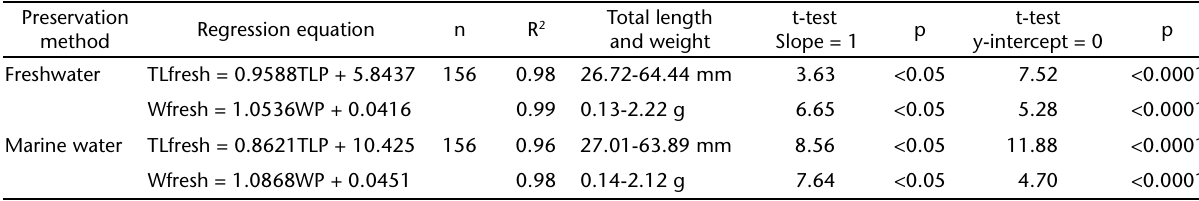
Table I. Correction equations to estimate the weight and total length for juvenile A. brasiliensis